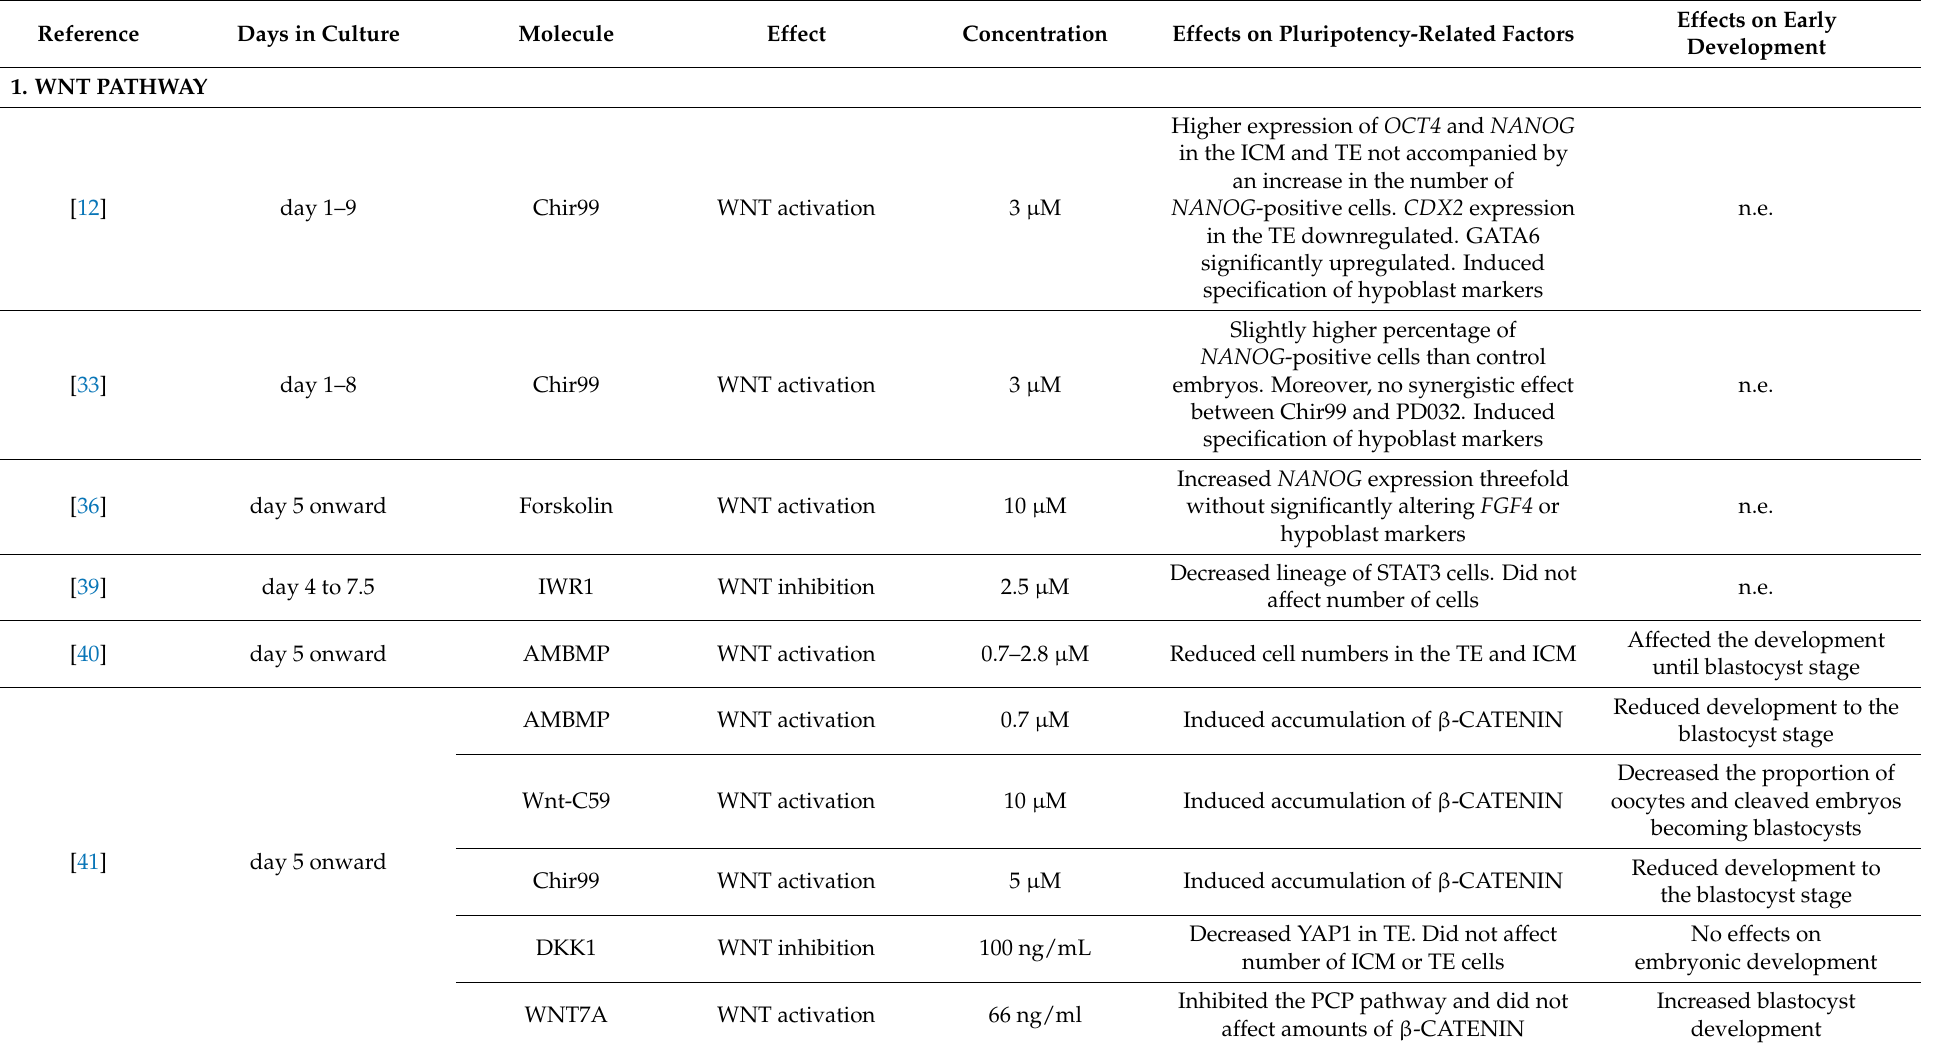
Table 1. Small-molecule inhibitors and their effects on pluripotency and development of bovine